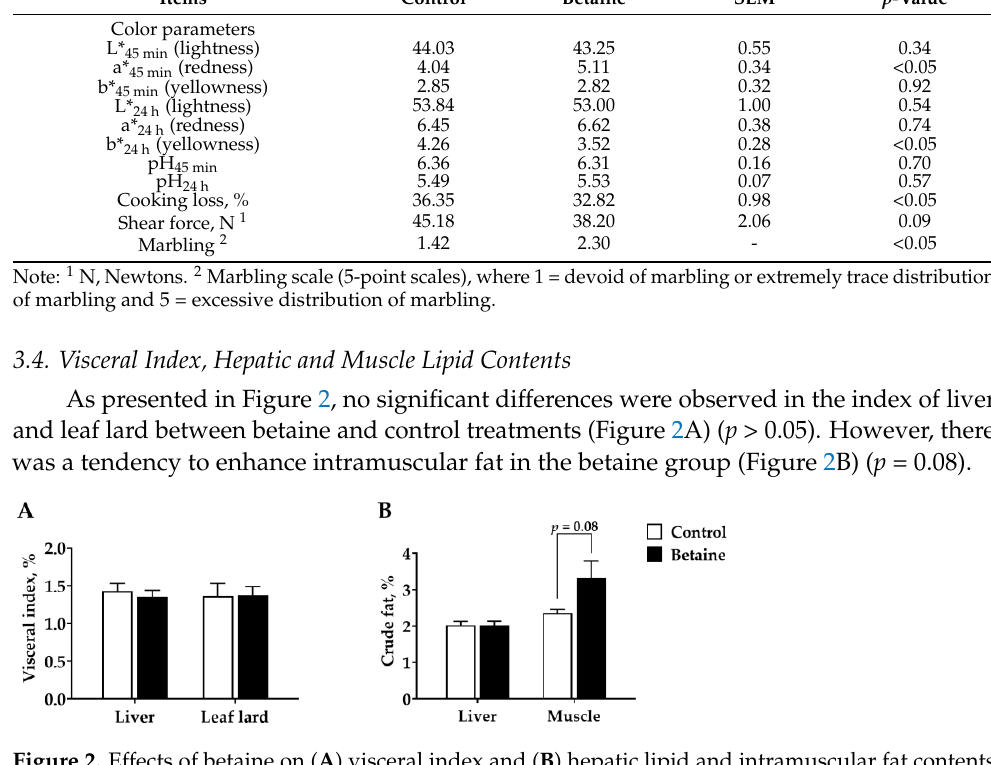
Figure 2. Effects of betaine on ( A ) visceral index and ( B ) hepatic lipid and intramuscular fat contents in growing-finishing pigs.